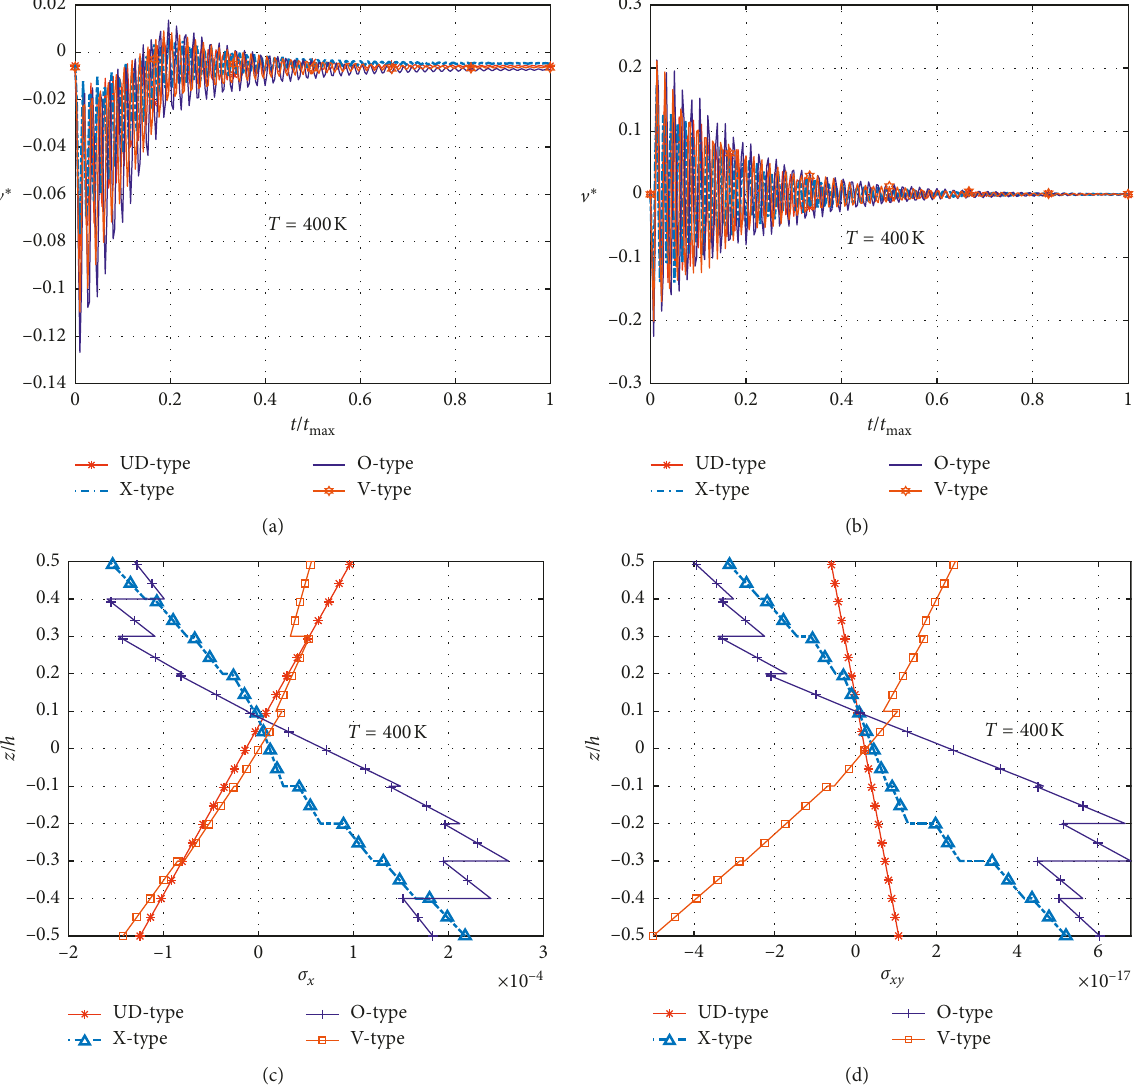
Figure 6: Nondimensional deflection, stress, and velocity of the center point at T (d) stress σ xy Table 5: Effect of four different types of graphene reinforcement on nondimensional velocity and deflection of the center point. Temperature T Maximum value w X-type